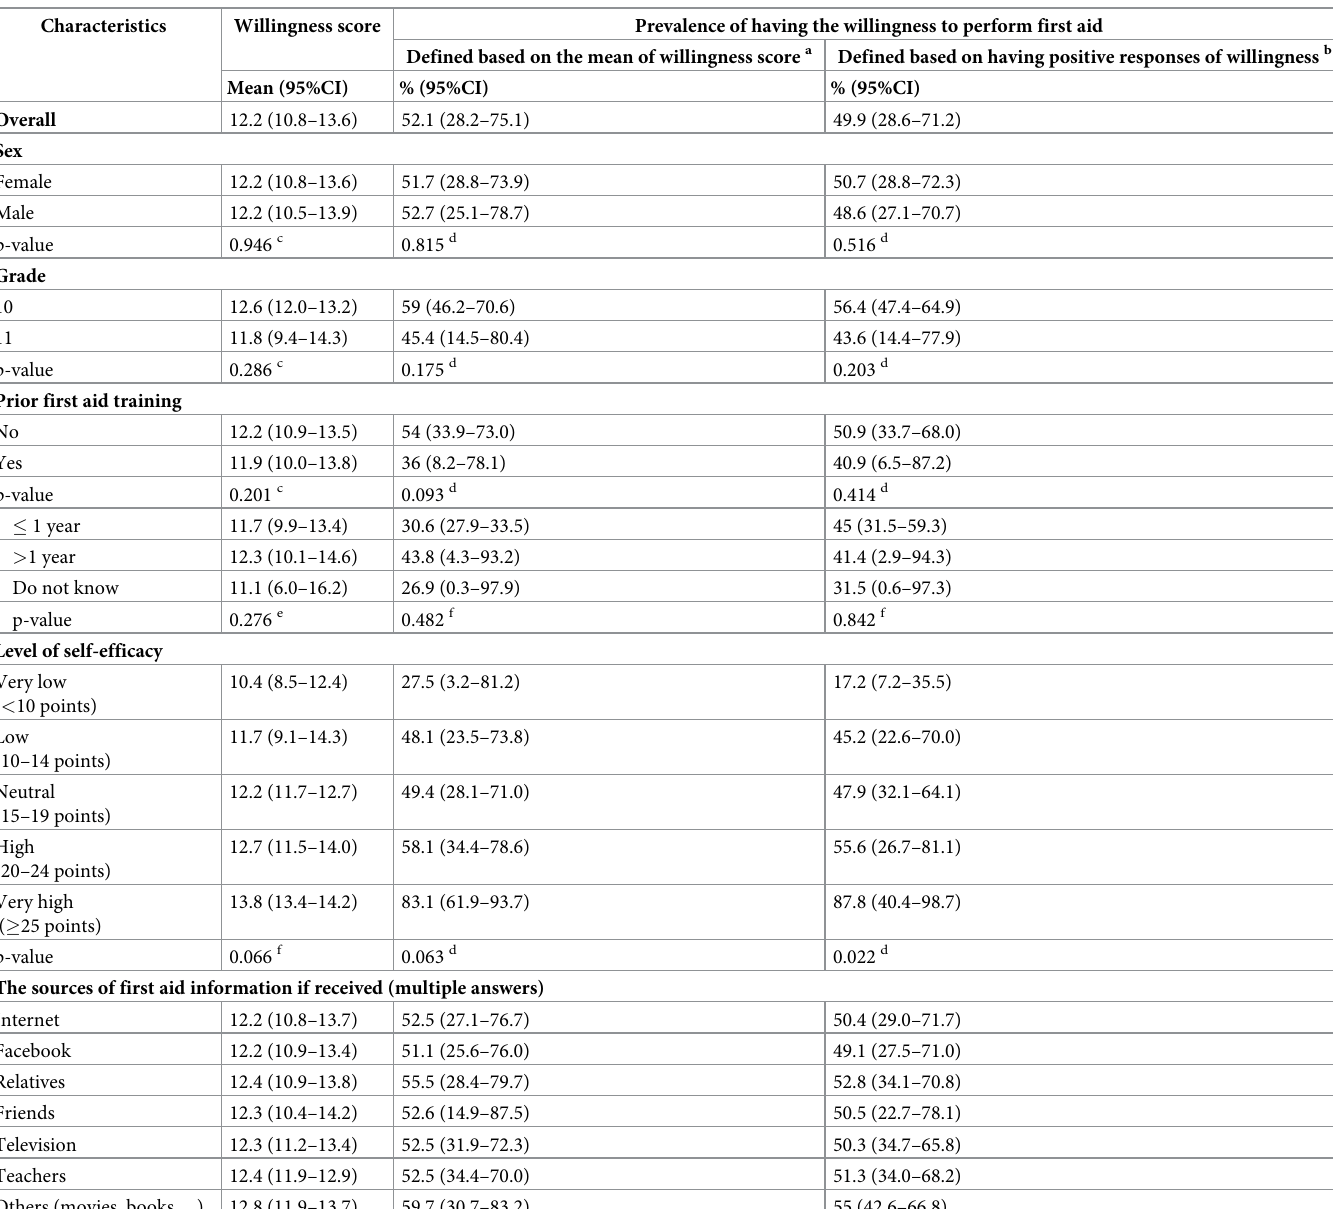
Table 3. The weighted prevalence of willingness of students to perform first aid.